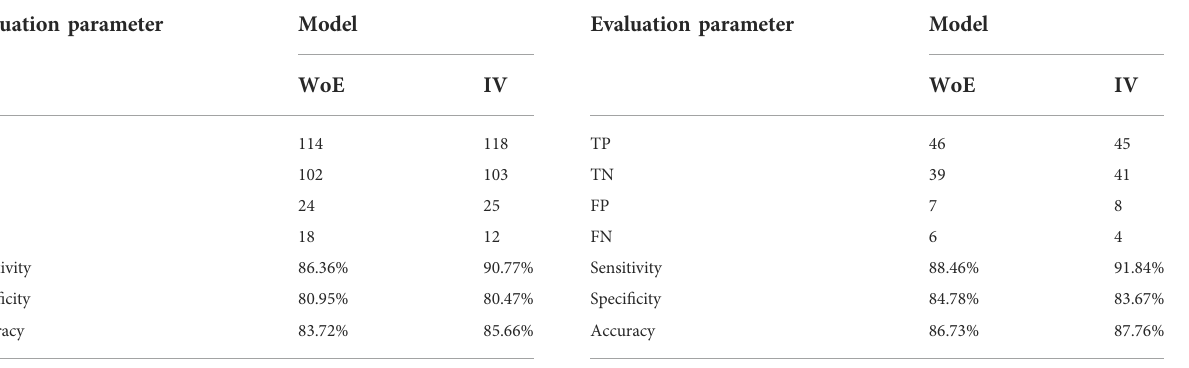
TABLE 4 Model performance using the training dataset. TABLE 5 Model performance using a validation